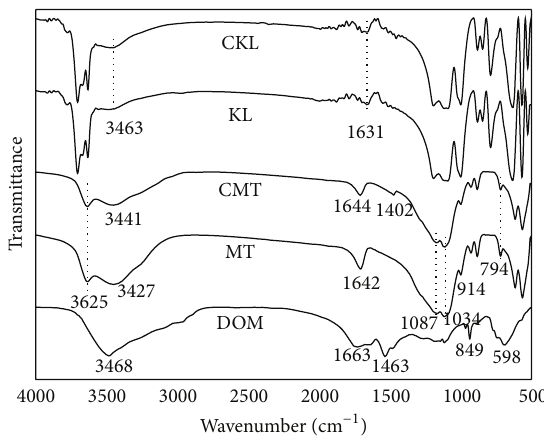
Figure 2: FTIR spectra of the bare clays, their complexes, and the dried DOM